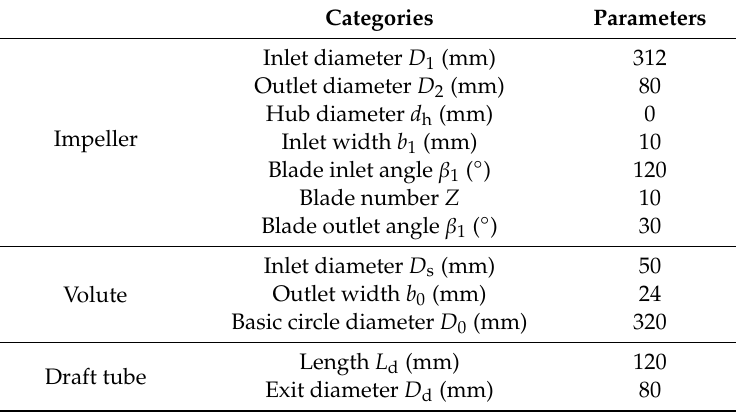
Figure 3. Structure of modified PAT. ( a ) Structure of selected PAT; ( b ) modified impeller of PAT. Table 1. Geometrical parameters of pump as turbine (PAT ) .